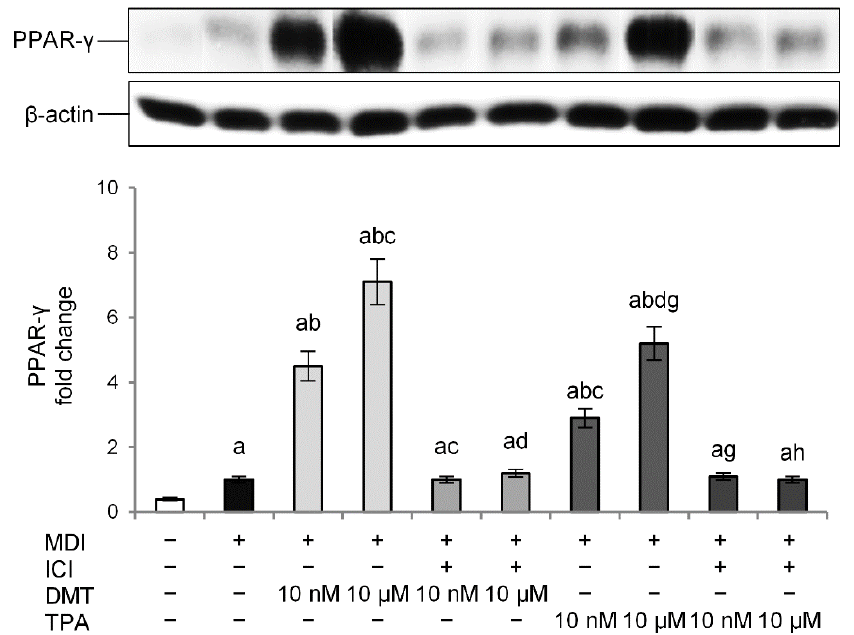
Figure 5. Effect of the ER antagonist ICI on the obesogenic effect of p-phthalates: PPAR- γ expres- sion. 3T3–L1 preadipocytes were cultured in differentiation medium (MDI) containing p-phthalates (10 nM and 10 µ M) and ICI 10 nM for 10 days. Cells treated with MDI alone were used as controls. Undifferentiated cells were cultured in standard medium for 10 days. The densitometry results are reported as fold change compared to MDI. The intensity values of the PPAR- γ were normalized to the corresponding value of β -actin. All data are expressed as mean ± SD of three independent ex- periments. a p < 0.05 vs. undifferentiated cells; b p < 0.05 vs. MDI; c p < 0.05 vs. DMT 10 nM; d p < 0.05 vs. DMT 10 µM; g p < 0.05 vs. TPA 10 nM; h p < 0.05 vs. TPA 10 µM.